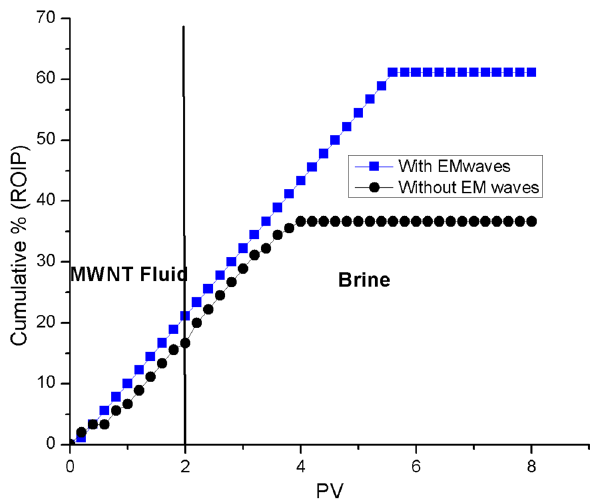
Fig. 3 Comparison of cumulative ROIP versus pore volume of MWCNT fluid injected in the absence and presence of EM waves